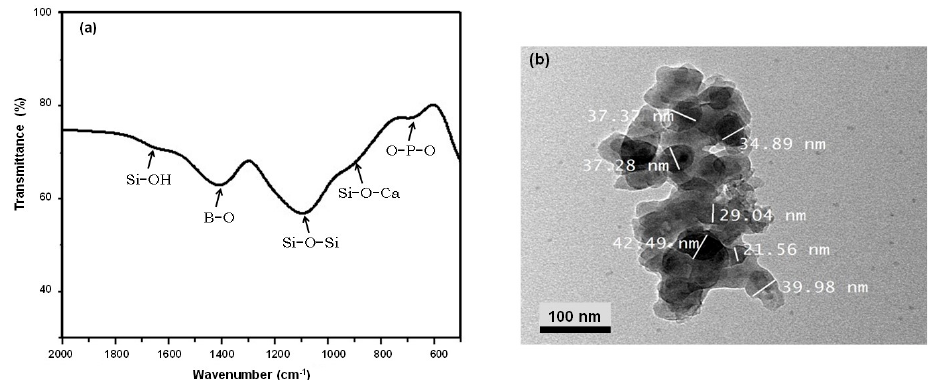
Figure 2. Characterization of BBG nanoparticles: ( a ) FT-IR spectrum and ( b ) TEM micrograph.